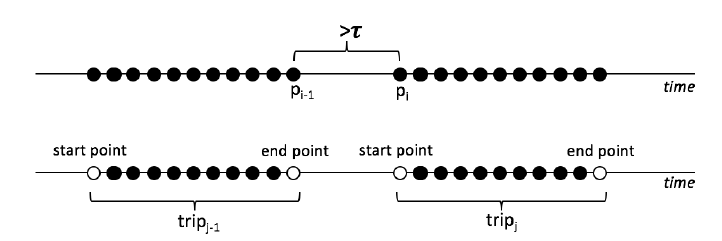
Figure 2. Trip segmentation using dwell time